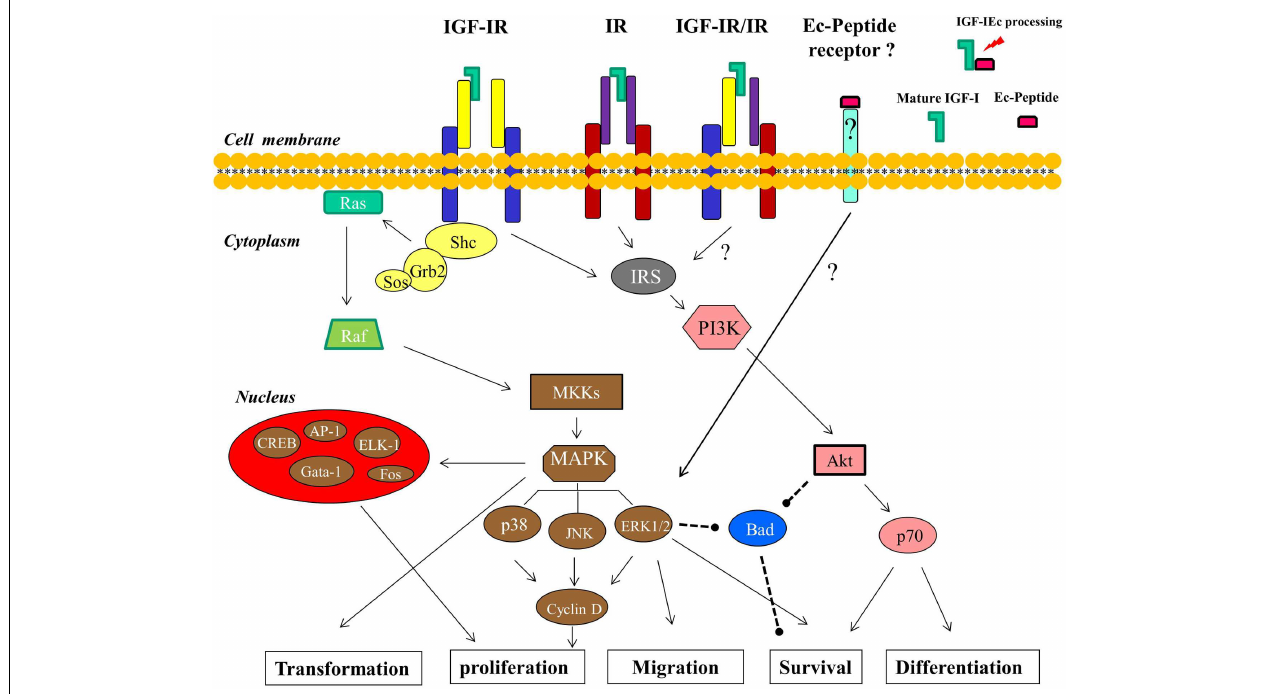
receptor, which in its turn can activate ERK1/2, is postulated.The arrows indicate an activating effect and the dashed lines represent an inhibitory